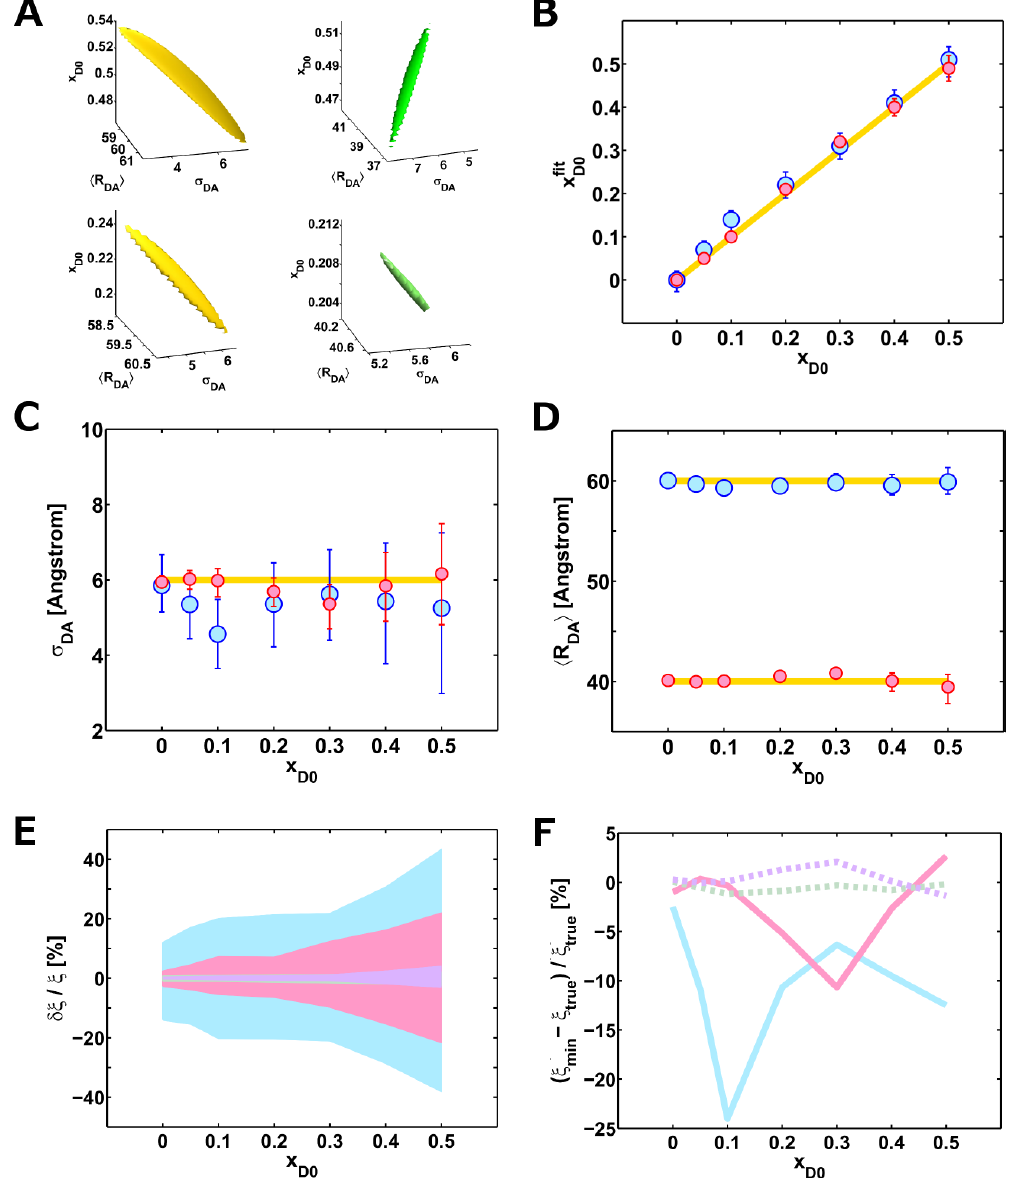
Figure 3. Results from the analysis of the artificial lifetime decays. ( A ) Representative set of confidence surfaces at one standard deviation (68.3%) from the minimum calculated for low (yellow) and high (green) FRET efficiencies. The donor-only fractions x ( top ) and 0.2 ( bottom ). ( B – D ) Estimated parameters ( x function of the donor-only fraction for high (pink) and low (light blue) FRET efficiencies. The yellow lines represent the true values. The error bars are also indicated. The percentage relative errors ( E ) and accuracies ( F ) are shown as a function of the donor-only fraction for different true parameter values and FRET efficiencies. Color code: (i) ξ = σ state (light blue) and high FRET state (pink); and (ii) ξ = (cid:104) R green) and high FRET state